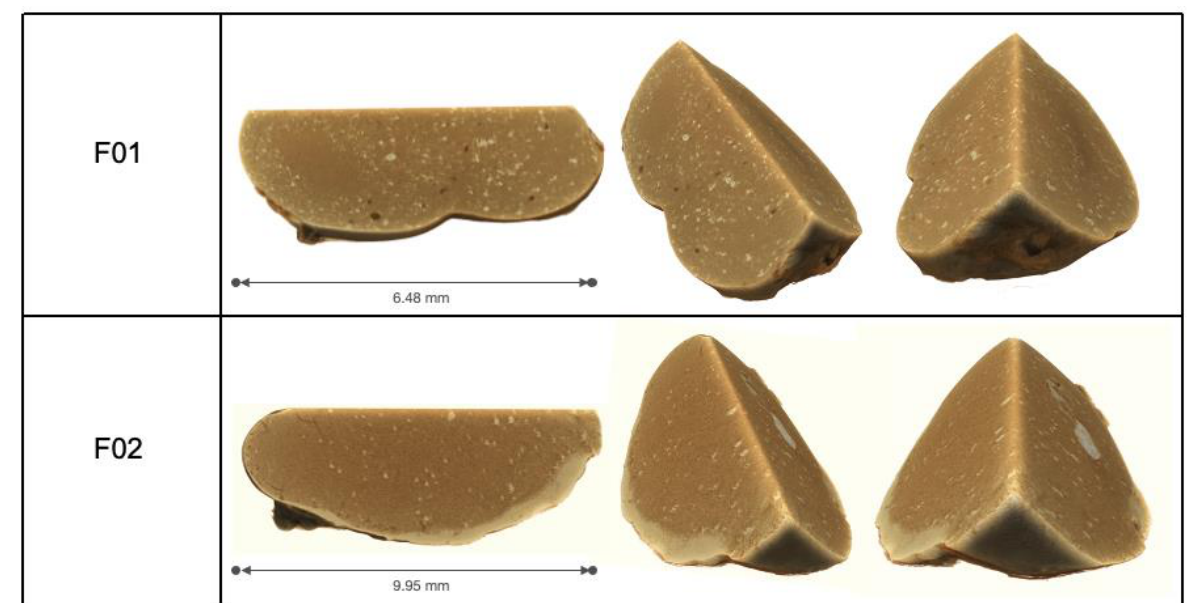
Figure 8. Three-dimensional X-ray microtomography reconstructions of PEG–PTMC triblock (F01) or diblock (F02) depots explanted 28 days post administration to rats.